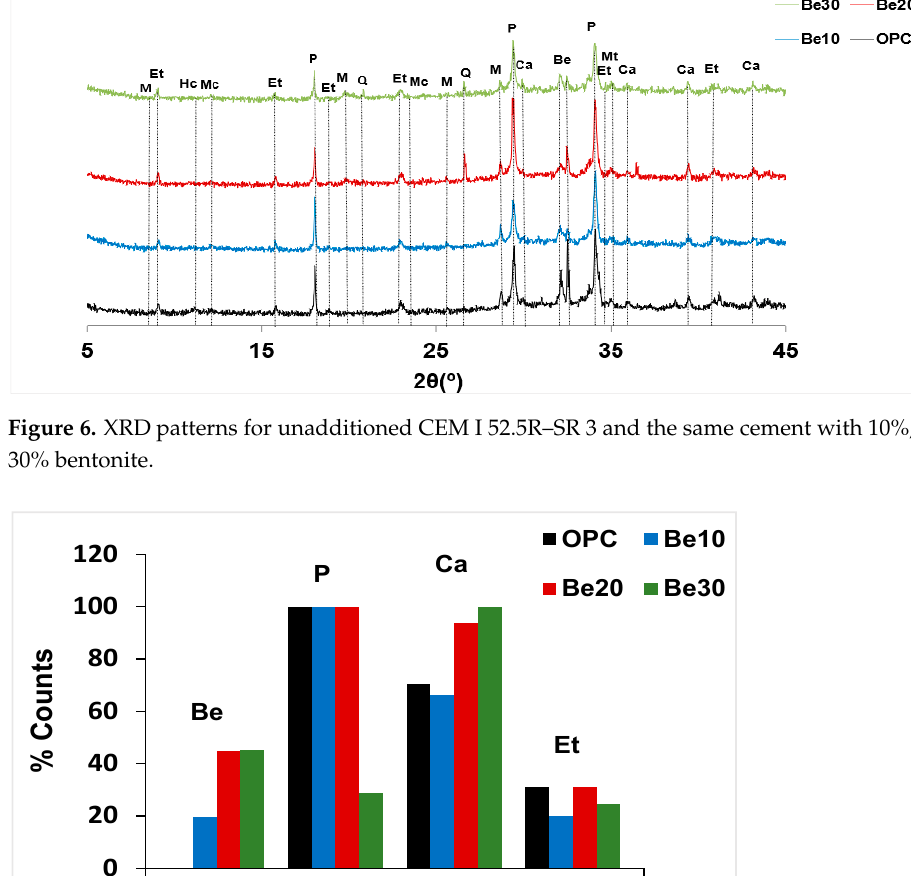
Figure 7. Crystalline phases identified on the XRD patterns for the reference and bentonite-bearing mixes: counts (%).